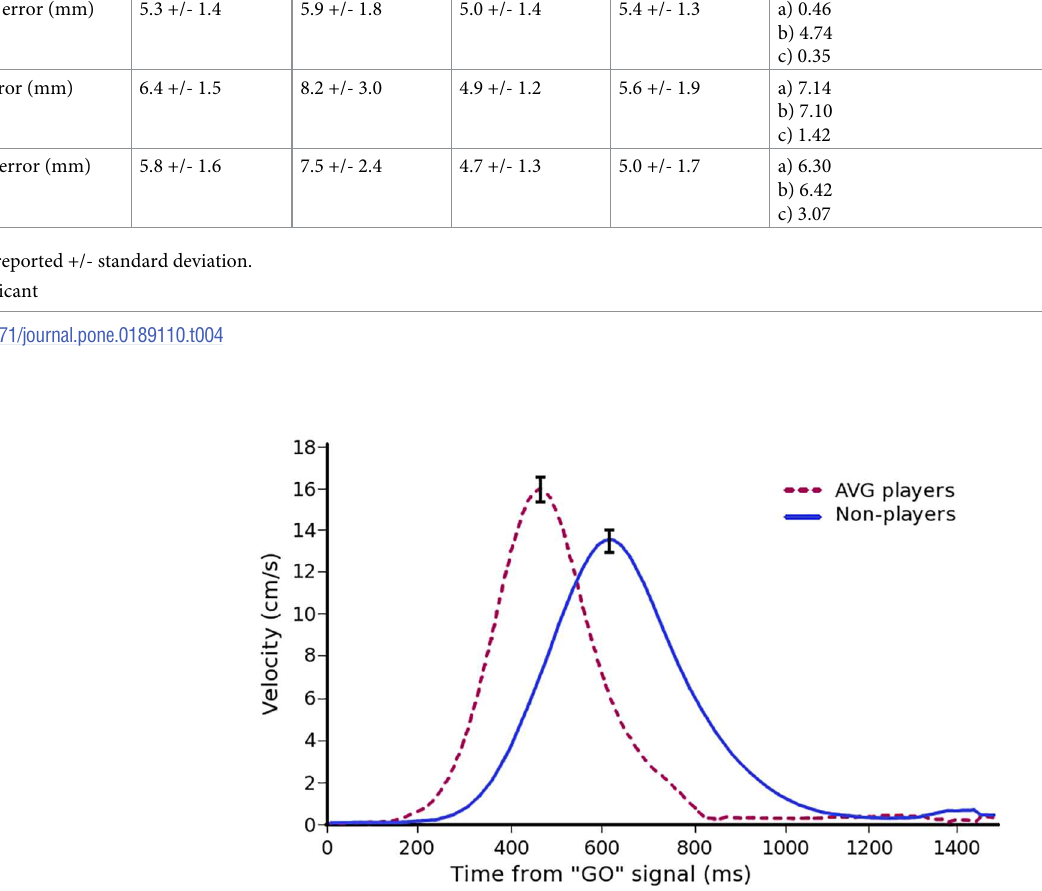
Fig 5. Kinematic measures of arm movements in AVG players and non-players. Mean arm movement velocity profiles after the “Go” signal for the AVG players (dashed burgundy line) and non-players (solid blue line). Velocity profiles are pooled for the Standard and Non-standard visuomotor conditions. Error bars represent SEM.